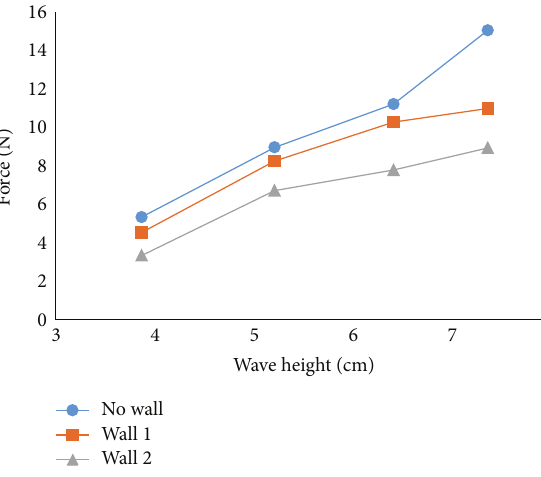
Figure 5: Force reduction by sea walls.